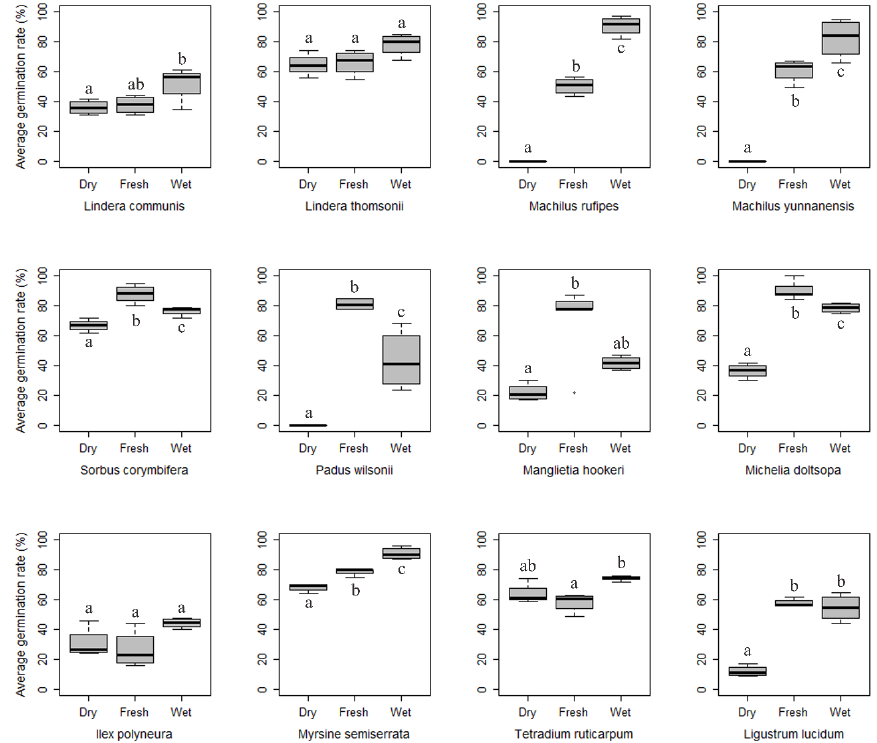
Figure 2. Average germination rates of seeds under different storage treatments. Dry—dry storage; Fresh—fresh seed; Wet—wet storage. Treatments with the same letter are not significantly different (Tukey HSD test, p > 0.05).